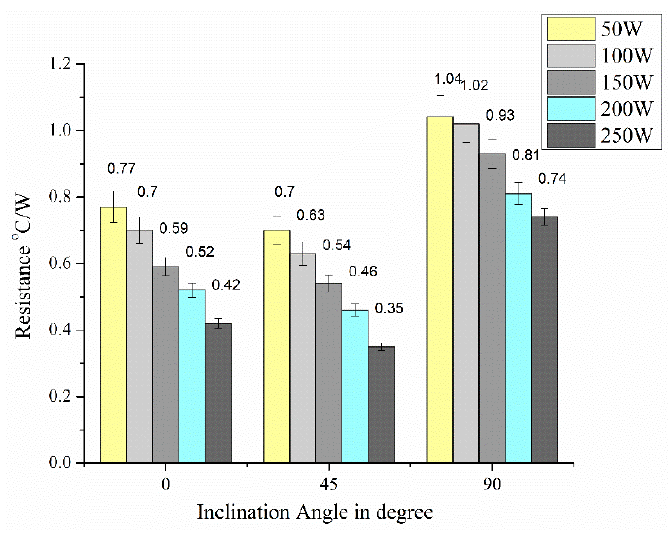
Figure 4. Thermal Resistance with NUAS Vs setting angle.